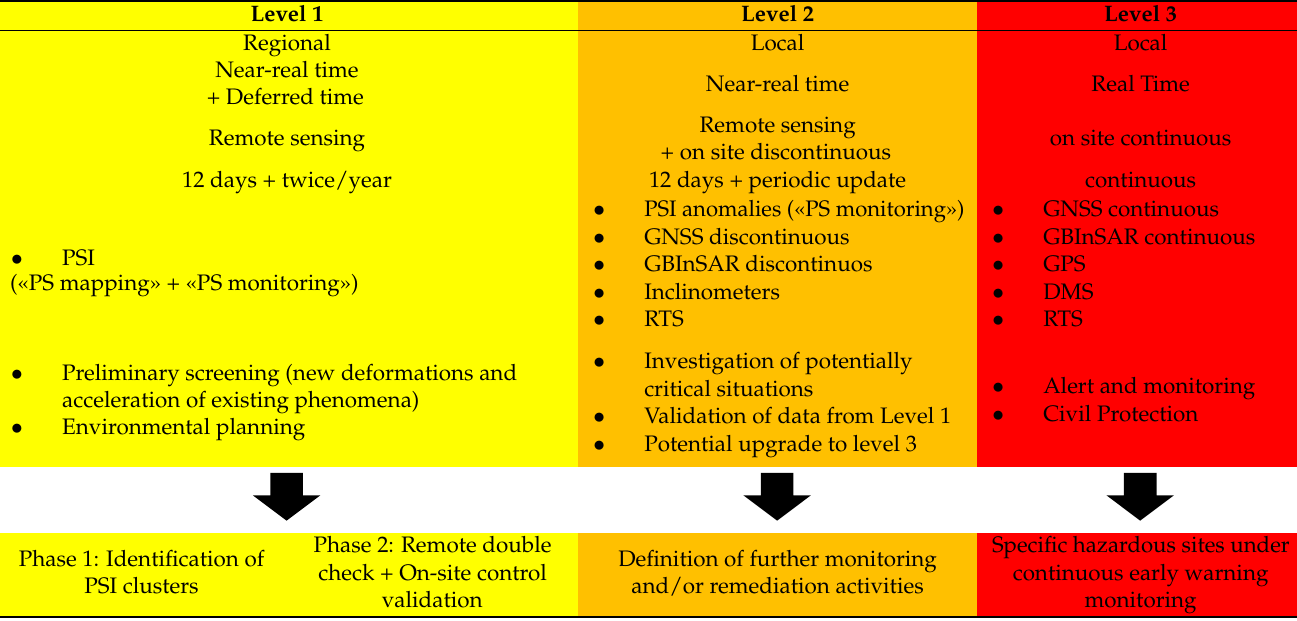
Table 1. Scheme of the three monitoring levels and related actions in the monitoring network in the Valle D’Aosta regional Civil Protection (VARCP).